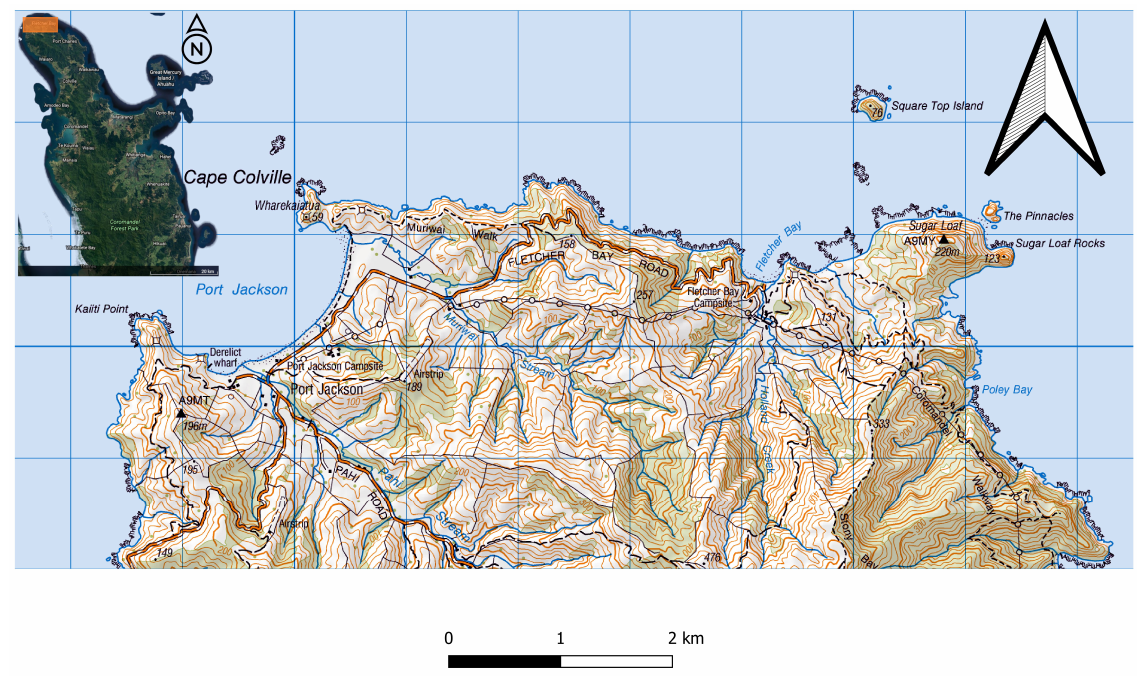
Figure 2. Detail from the topographic map of New Zealand (Moehau NZTopo-AZ34) 1:50,000 scale showing the territory of the northern part of the Coromandel Peninsula: Port Jackson, Fletcher Bay, and Port Charles. The small satellite image (on the top left side) shows the whole territory of the Coromandel